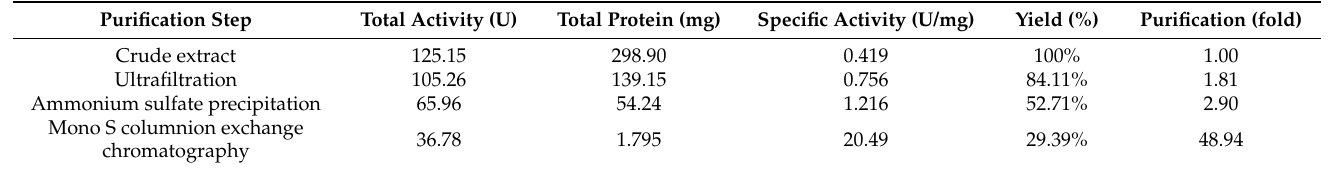
Table 2. Summary of the purification procedure for laccase